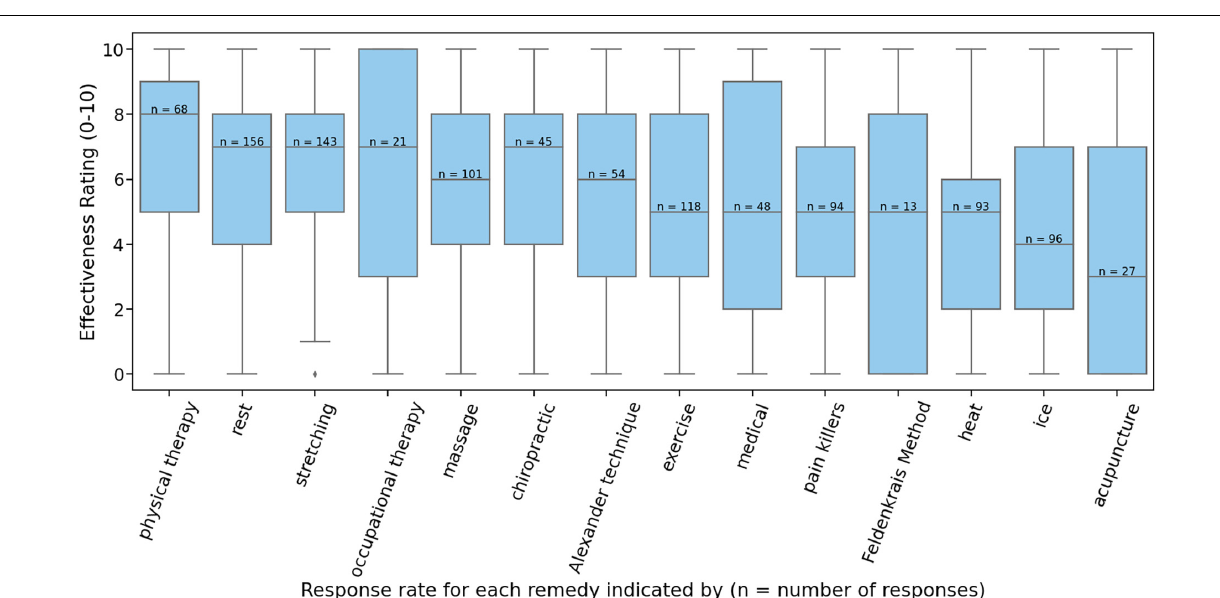
FIGURE 9 | Effectiveness ratings (scale of 0 to 10) of treatment